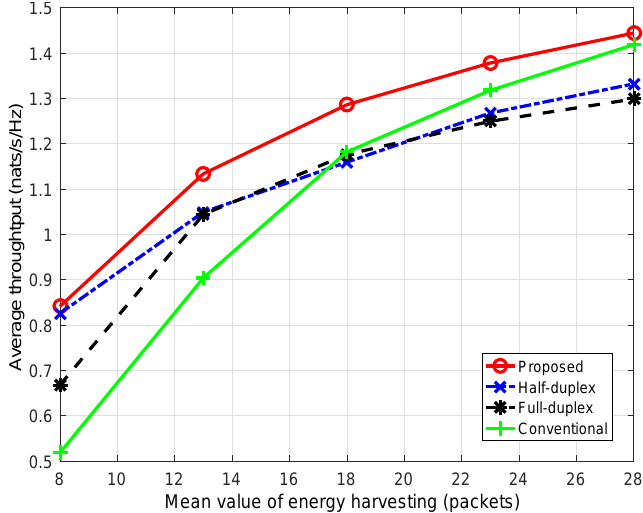
Figure 9. Average throughput according to the mean value of energy harvesting. The simulation was run for 1000 time slots, and the loop was executed 100